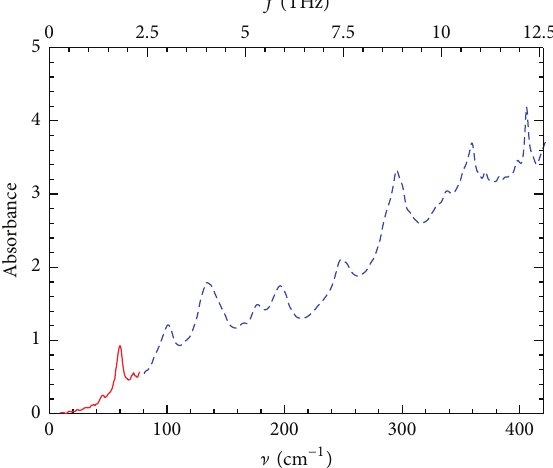
Figure 2: THz-TDS measurement results. The solid line corre- sponds to N -acetyl-D-glucosamine dispersed in polyethylene pow- der at 18wt% and the dashed line to a reference pellet of pure polyethylene.